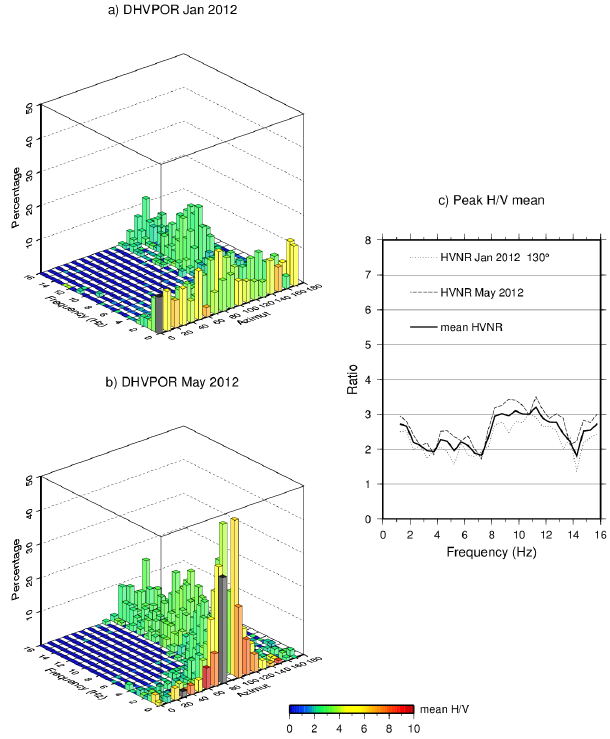
Fig. 10. Results of noise measurement at site T6N (1627 landslide): Fig. 10 - Results of noise measurement at site T6N (1627 landslide): DHVPOR histograms relative 2 DHVPOR histograms relative to measurements of January (a) and to measurements of January (a) and May (b) 2012 and mean values of H/V peaks oriented due 3 May (b) 2012 and mean values of H/V peaks oriented due 130 ◦ N; N130°; thick solid line represents the average of noise H/V peak values derived from different 4 thick solid line represents the average of noise H/V peak values measurements. 5 derived from different